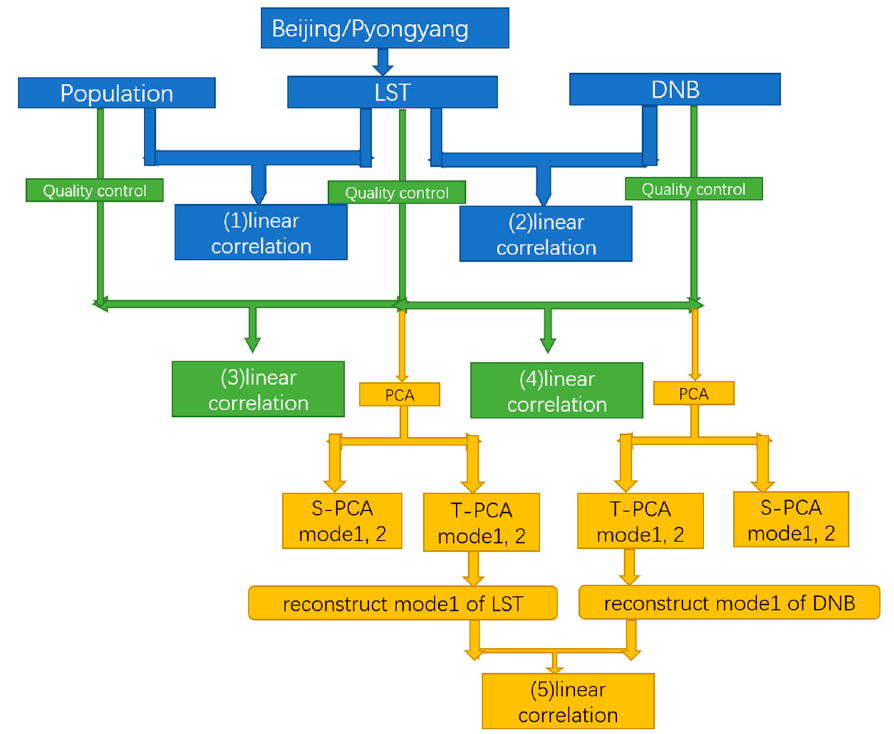
Figure 12. The structure diagram of the data processing and analysis.